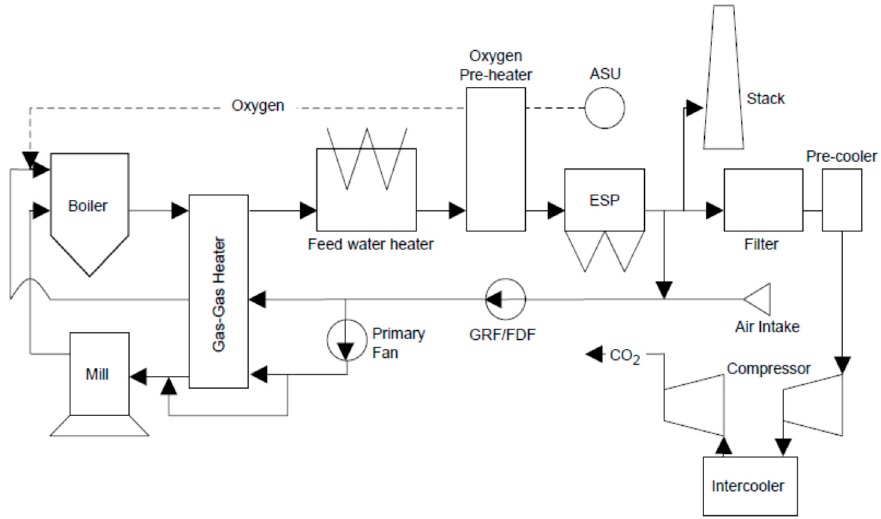
Figure 1. Oxy fuel firing in the coal-fired power plant [11].